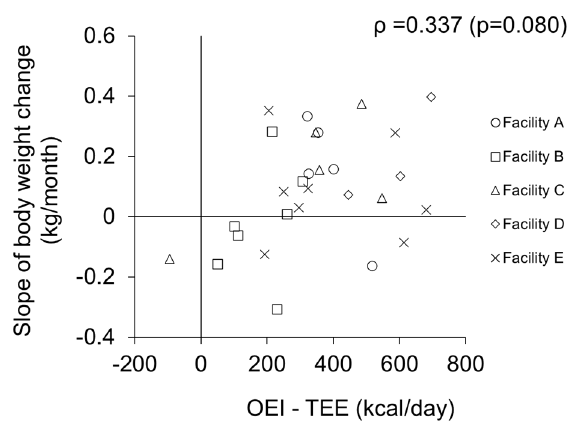
Figure 4. Relationship between energy gap and slope of weight change ( n = 28).